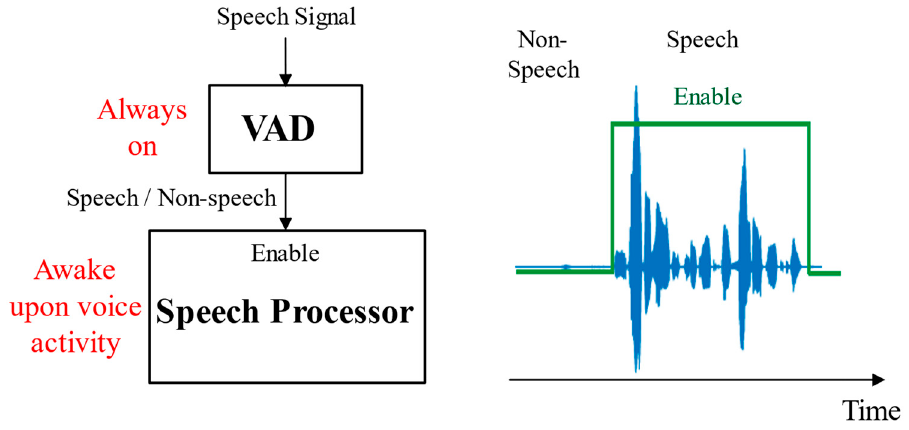
Figure 1. Always-on voice activity detection as a wakeup mechanism.